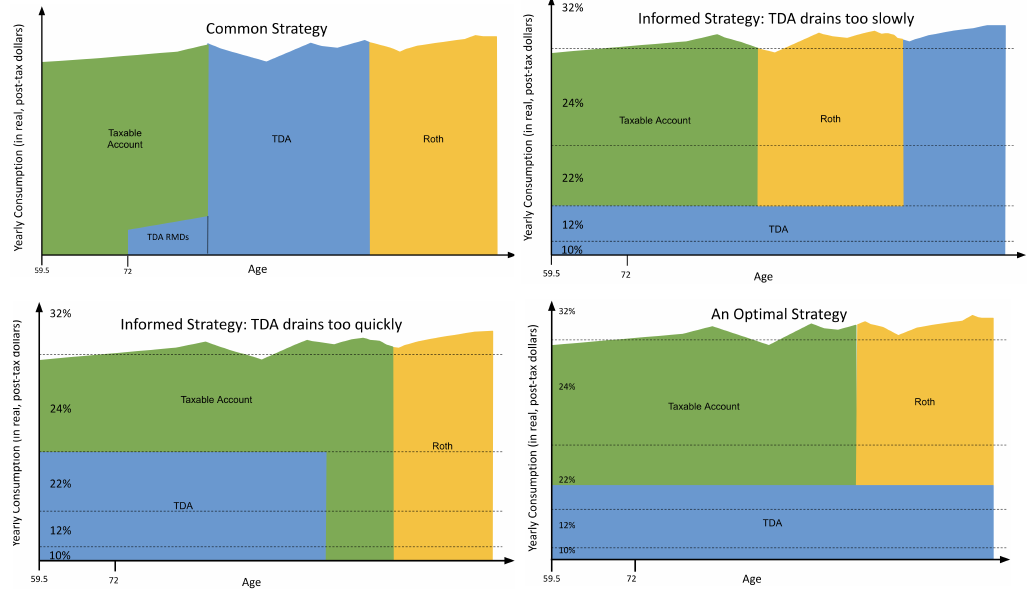
Figure 1. Four tax strategies. All consumption amounts are in real, post-tax dollars. Upper left panel: The common strategy, withdrawing from the taxable account (plus TDA RMDs), then the TDA, then the Roth account. Upper right panel: The informed strategy for withdrawing TDA money through the 12% bracket. Lower left panel: The informed strategy for withdrawing TDA money through the 22% bracket. Lower right panel: Our strategy for optimizing the TDA withdrawal rate. The height of the blue TDA rectangle corresponds to the value of L